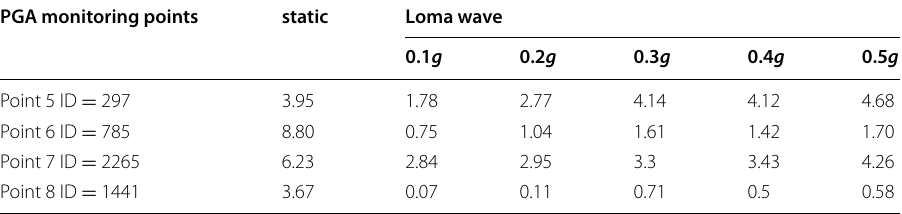
Table 3 Peak maximum principle stress of points 5–8 (10 5 Pa) PGA monitoring points